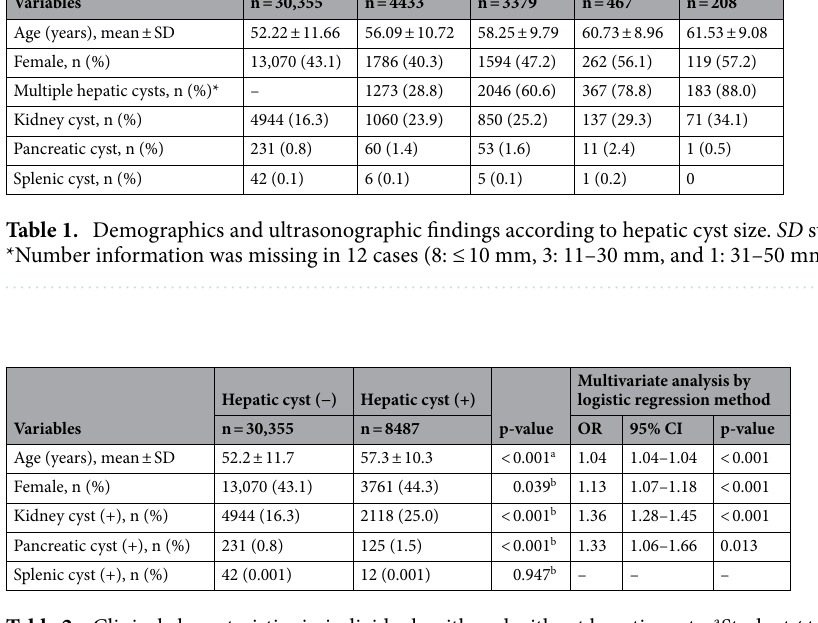
Table 2. Clinical characteristics in individuals with and without hepatic cysts. a Student t test, b Chi-squared test. SD standard deviation, OR Odds ratio, CI confidence